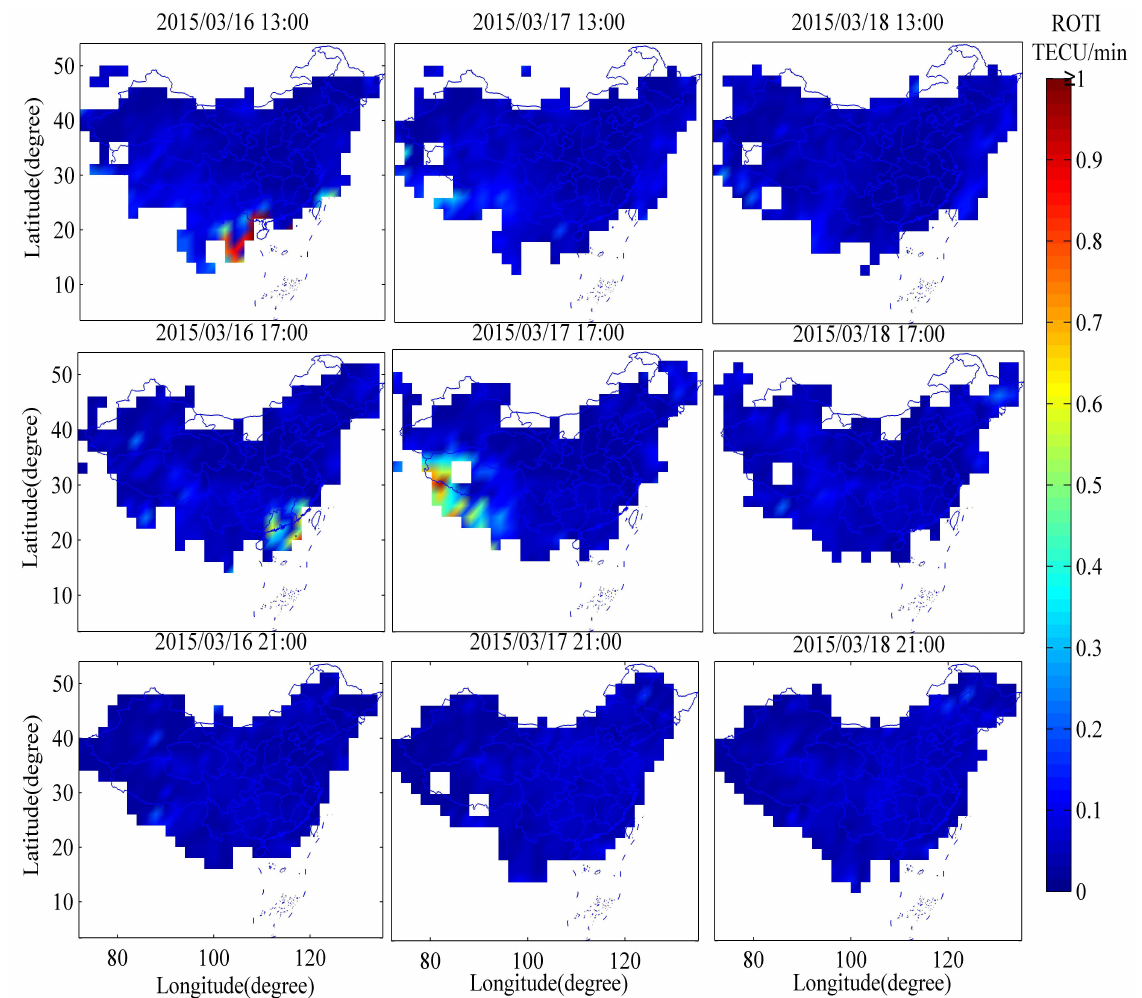
Figure 6. Distribution of the ROTI at UTC 13:00, 17:00, and 21:00 from 16–18 March 2015 (unit =